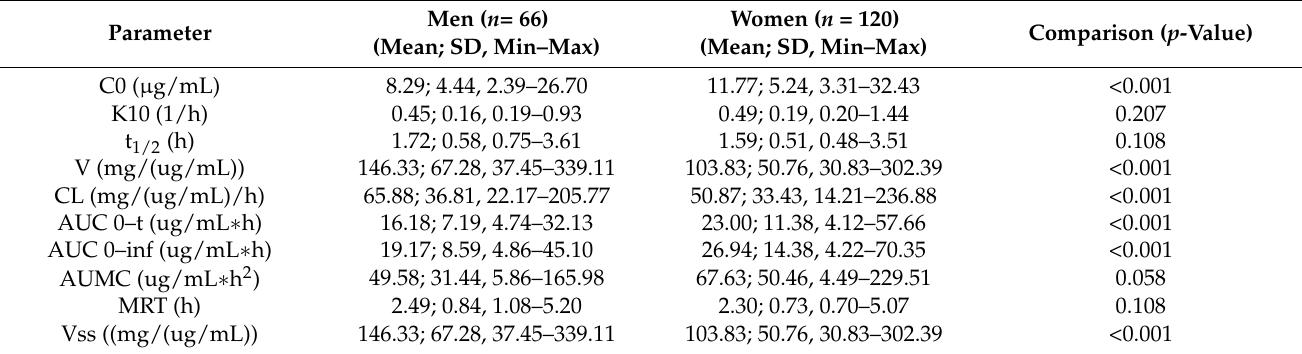
Table 3. Effect of sex in acetaminophen